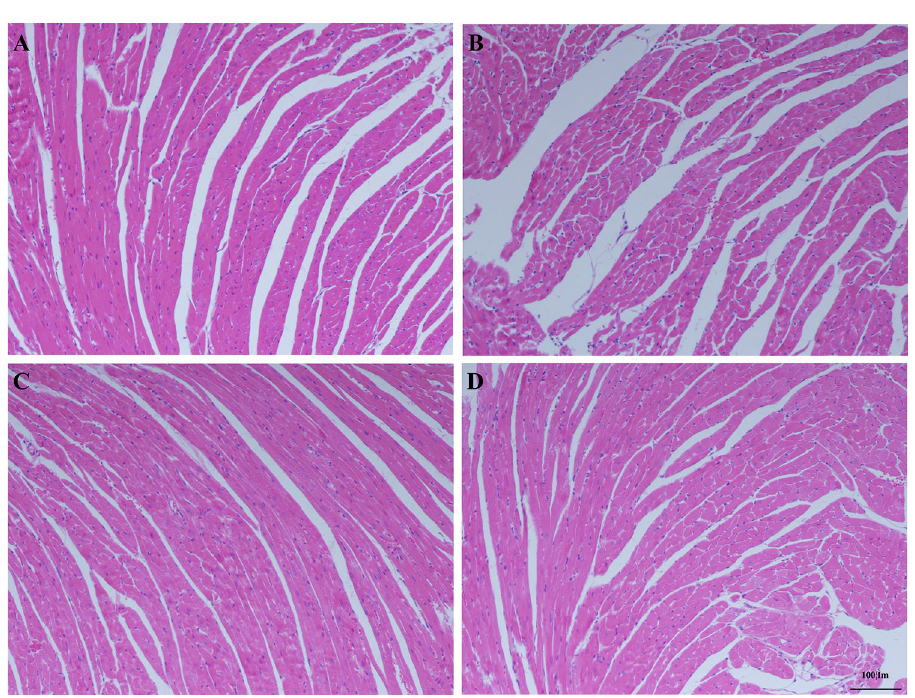
Figure 6. A photomicrograph of heart tissues used for morphological analysis. ( A ) Con group, ( B ) LPS group, ( C ) Ex group, ( D ) Ex + LPS group [( A – D ) × 100